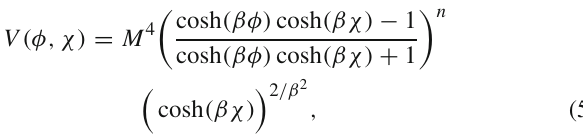
tionarytrajectorywiththeonsetofthenumericalsimulations(described in Sect. 4) and the end of inflation marked as green and yellow dots,